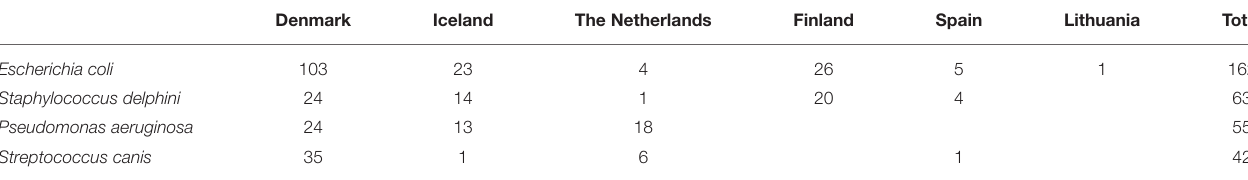
TABLE 1 | The 322 isolates included in the study, divided into species and country of